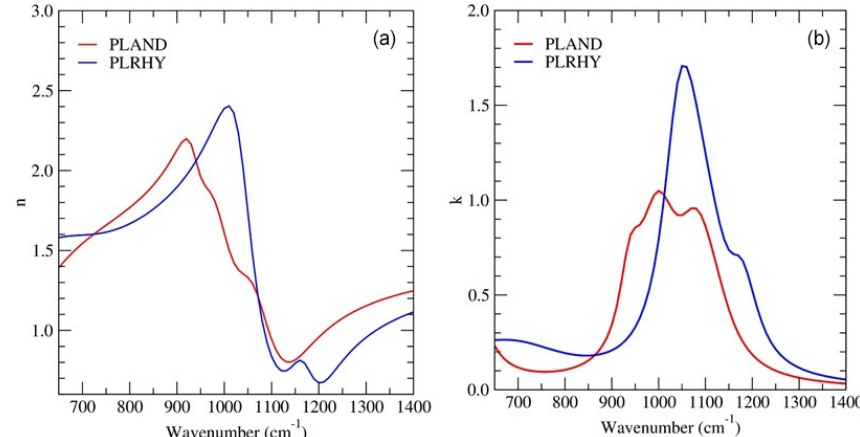
Figure 5. The same as Fig. 3 but for the PLAND (red) and PLRHY (blue) models. These RI models are the andesite and rhyolite models of PL1973. The refractive index (n,k) values were calculated using dispersion parameters and the equations in